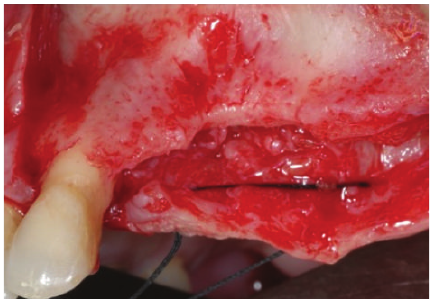
Figure 3: Clinical view of the bone after the elevation of the muco- periosteal flap.